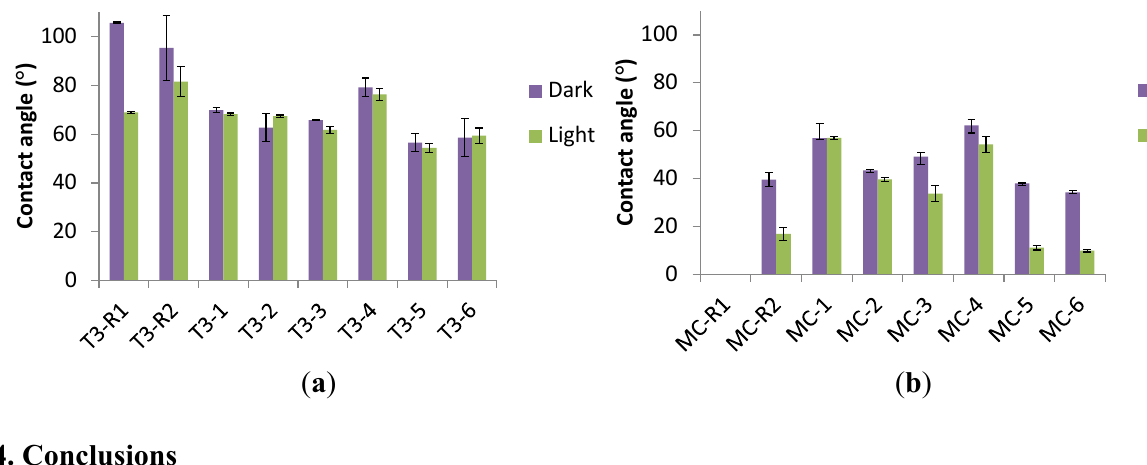
Figure 11. Water contact angle measurements for ( a ) TiO coupons after three month Brewery Trial (Coated area of MC-R1 was too small to